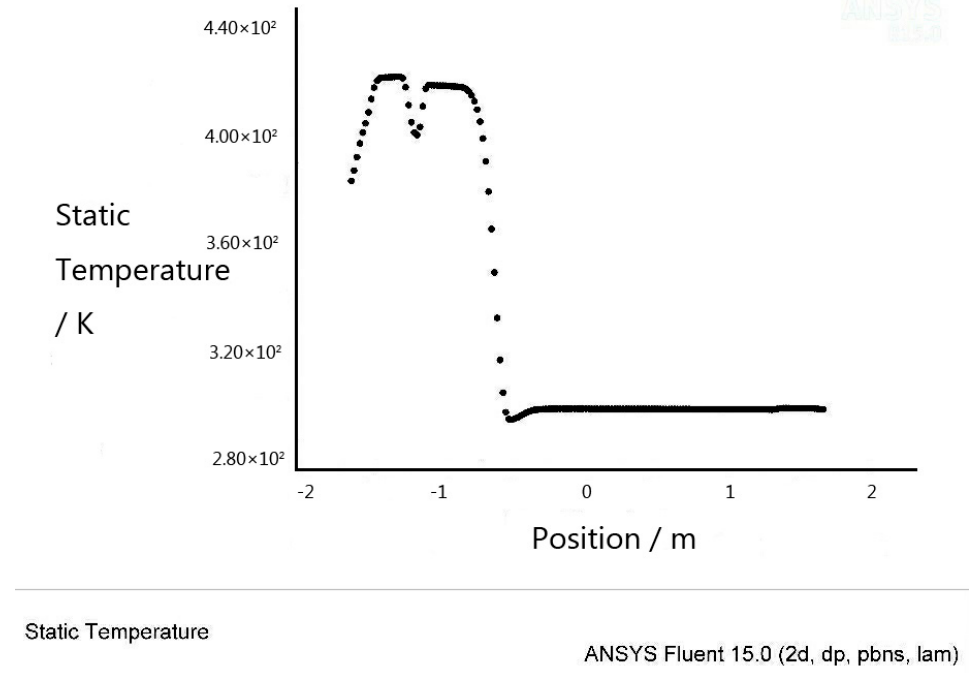
Figure 14. The temperature distribution of the dry coal outlet section.